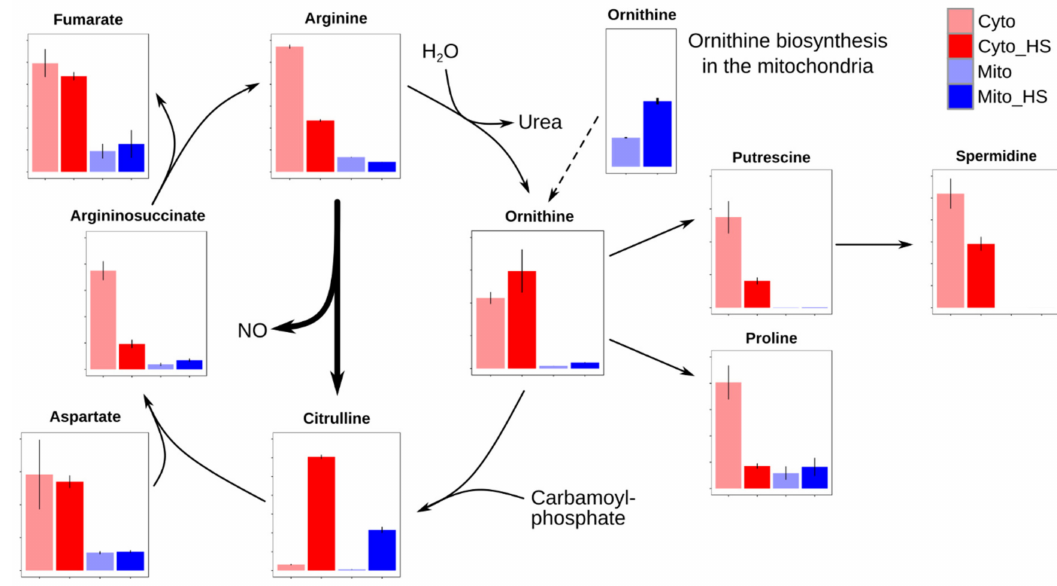
Figure 4. Relative abundance of arginine and related metabolites. The Y-axis indicates the relative abundance of each metabolite. Citrulline was highly accumulated after heat stress, while cytoplasmic argininosuccinate and arginine were reduced, indicating severely impaired arginine metabolism. The reason could be the direct conversion of arginine to citrulline, producing NO and leaving ornithine not dramatically